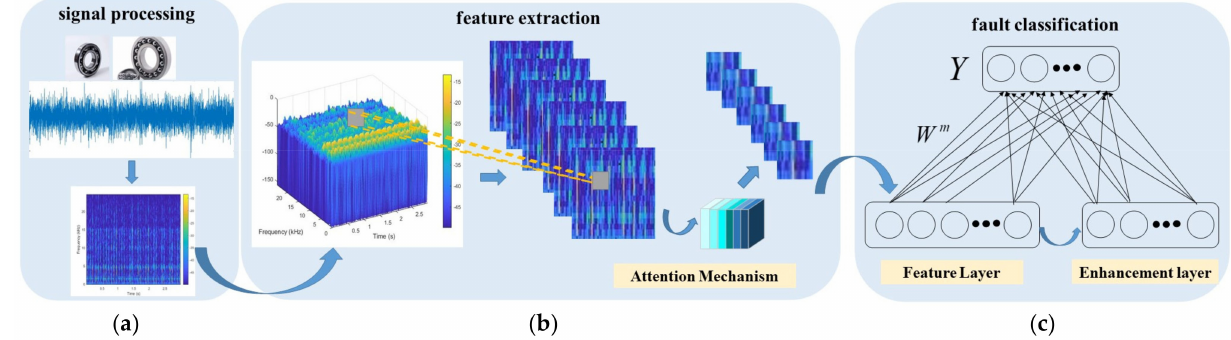
Figure 3. Framework of SECNN −